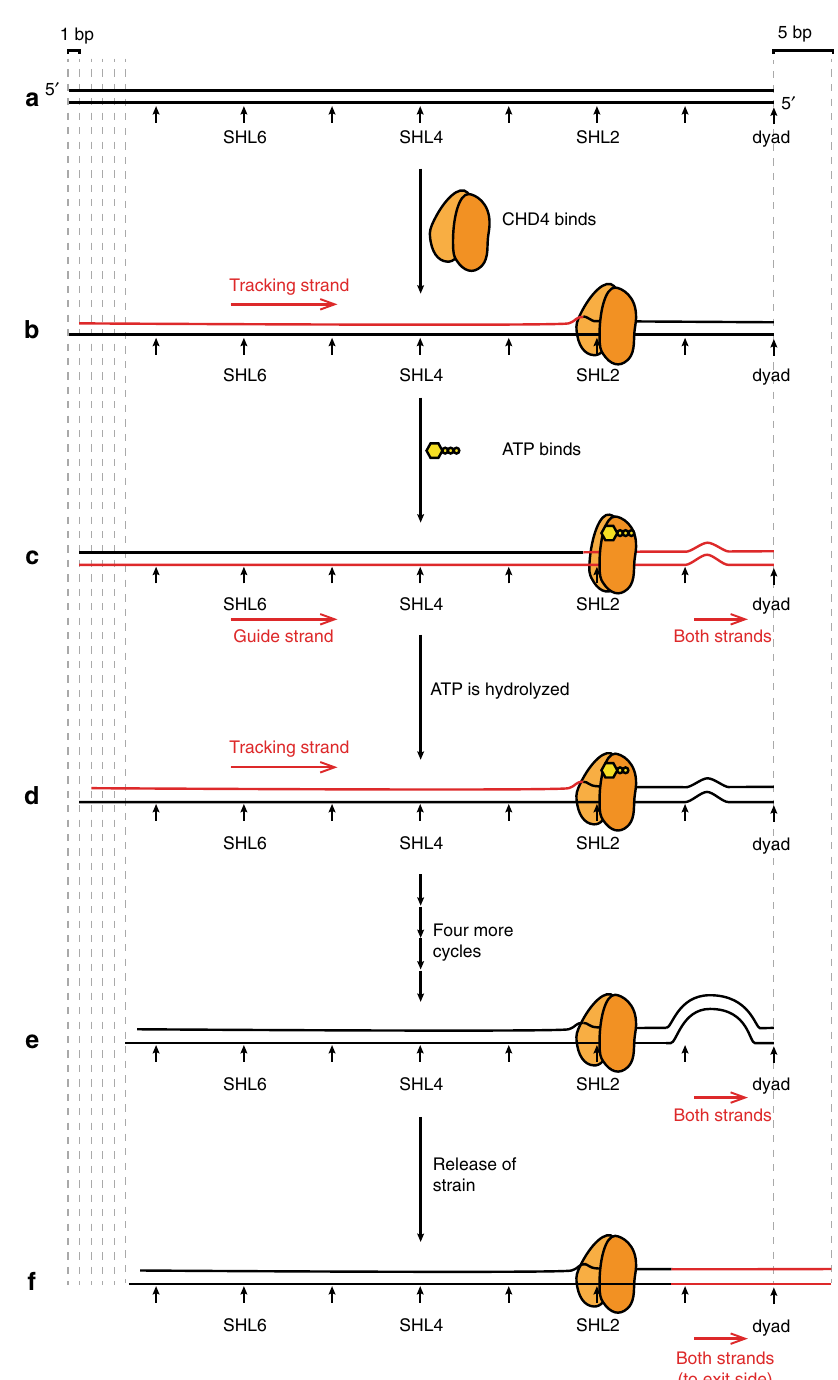
Fig. 7 A model for CHD4-driven nucleosome sliding. a Schematic of one-half of a nucleosomal DNA sequence. SHL positions are indicated. b Binding of the two-lobed ATPase domain of CHD4 (not drawn in scale) induces a 1-bp shift in the so-called tracking strand of the DNA, creating a distortion that reaches from the SHL2 site all the way back to the 5 ′ end of the tracking strand. The DNA segment moved by CHD4-induced remodelling is coloured in red in this and the following fi gures. c Binding of ATP induces a conformational change in CHD4, ‘ closing ’ the two lobes around the ATP. This change results in the guide strand ‘ catching up ’ to the tracking strand and then the movement of both strands by ~1 bp past CHD4, so that a small bulge (or other irregularity) forms in the region of the dyad. d Hydrolysis of ATP drives a return of CHD4 to the open conformation, inducing a second 1-bp movement of the tracking strand, analogous to that in part b , and initiating a second cycle of the same process. e Following four further cycles of ATP binding and hydrolysis, a large irregularity is built up near the dyad. f The strain induced by this irregularity causes a concerted rearrangement of the DNA such that 5 bp are expelled from the exit side. This whole cycle can in principle be repeated many